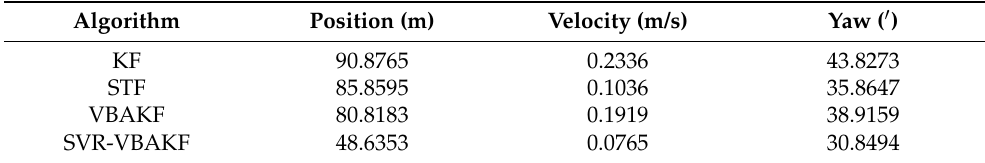
Table 3. Root mean square errors of position, velocity,